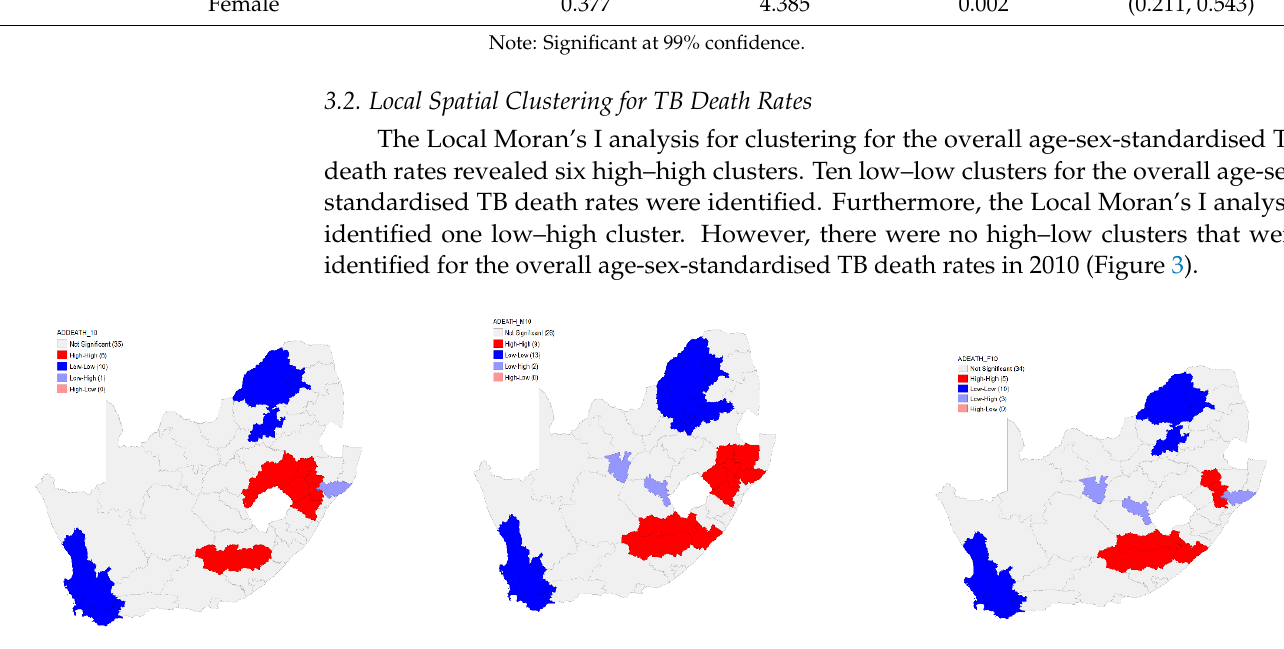
Figure 3. Local Moran’s I clustering of the overall ( left ), male ( middle ), and female ( right ) age-sex-standardised TB death